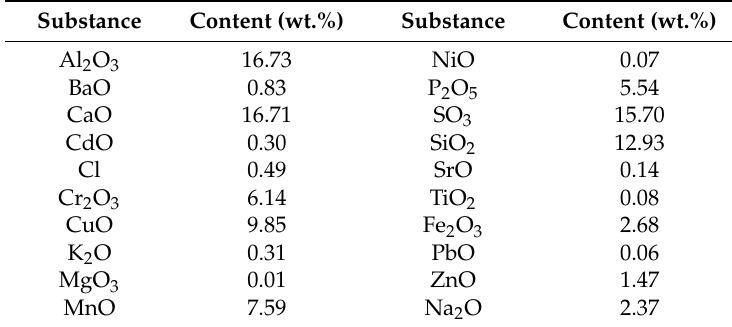
Table 5. Composition of the filtration cake inorganic fraction. Substance Content